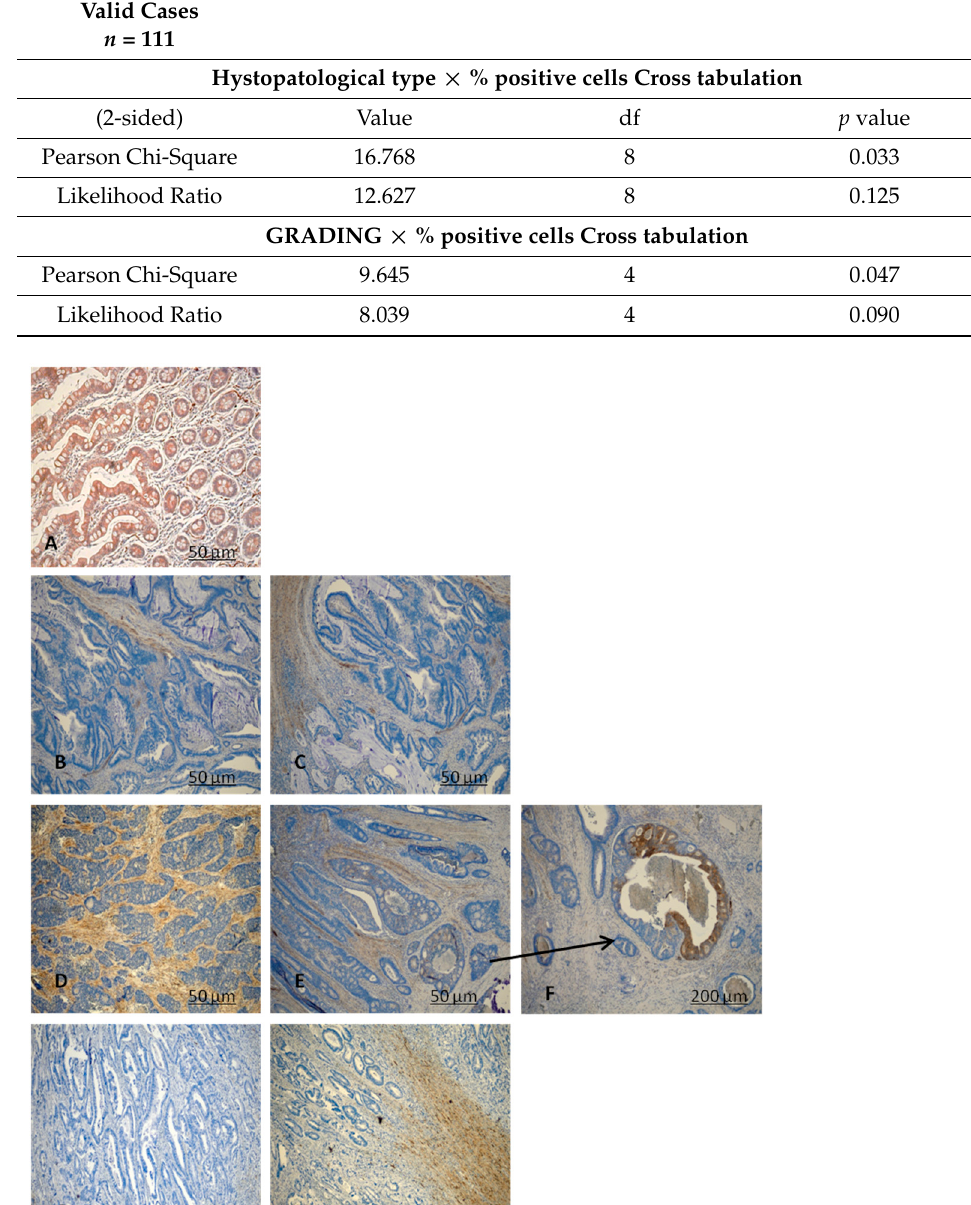
Table 2. Correlation of CRYAB positive cells with Hystopatological type and Grading of 111 CRC patients.